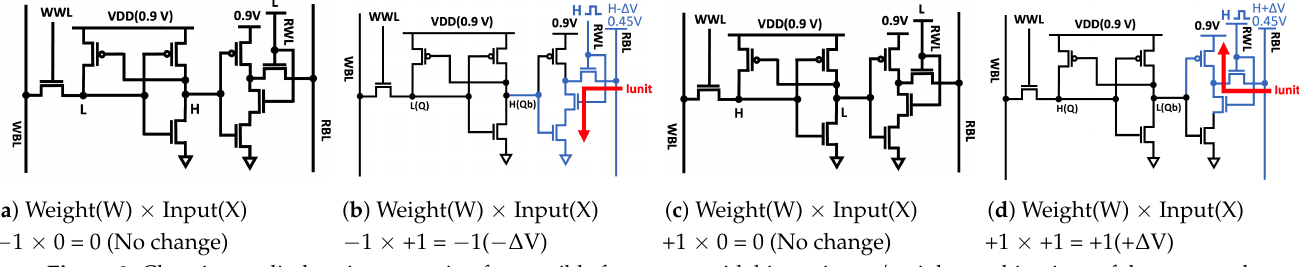
Figure 2. Charging or discharging operation for possible four states with binary input/weight combinations of the proposed SRAM-CIM. Table 2. Possible four states of the proposed SRAM-CIM with binary input/weight